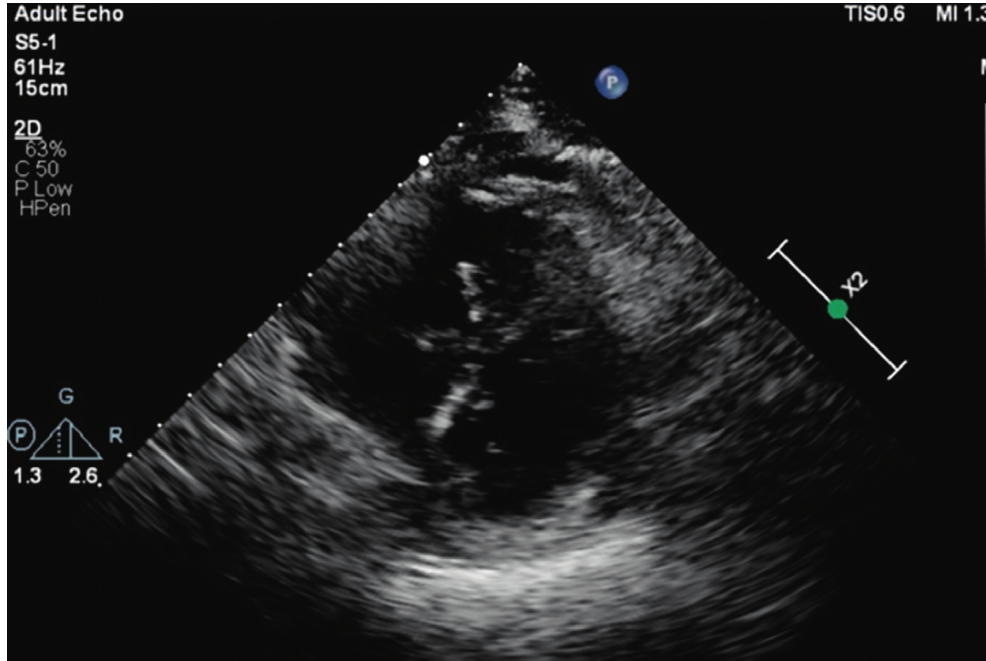
Figure 3: This image was obtained by the transthoracic echocardiogram using a parasternal short-axis view. There is increased pressure/ volume in the right ventricle and flattening of the interventricular septum creating a D-shaped right ventricle (known as a D-sign). In our case, this right ventricular strain is secondary to increased pressure in the pulmonary